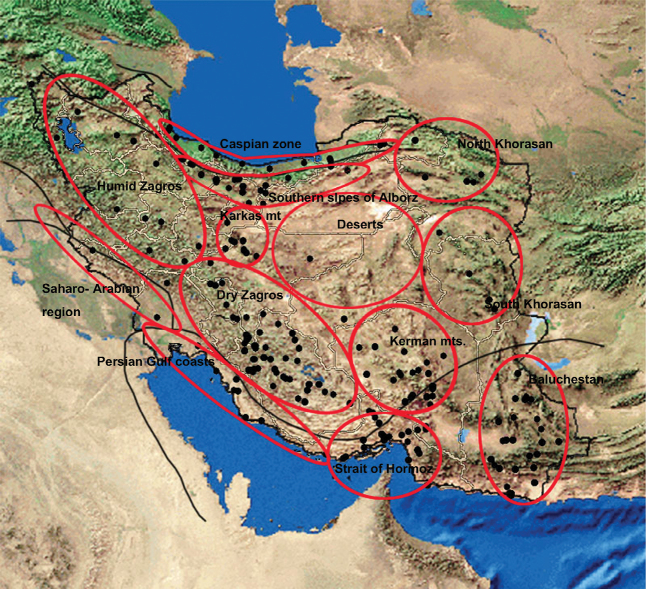
Distribution of endemic Fulgoromorpha of Iran, Phytogeographical regions (Black lines) (after Zohary 1973, altered by Frey and Probst 1986 and Primary divisions (Red lines) suggested for the distribution pattern of endemic planthoppers of Iran.